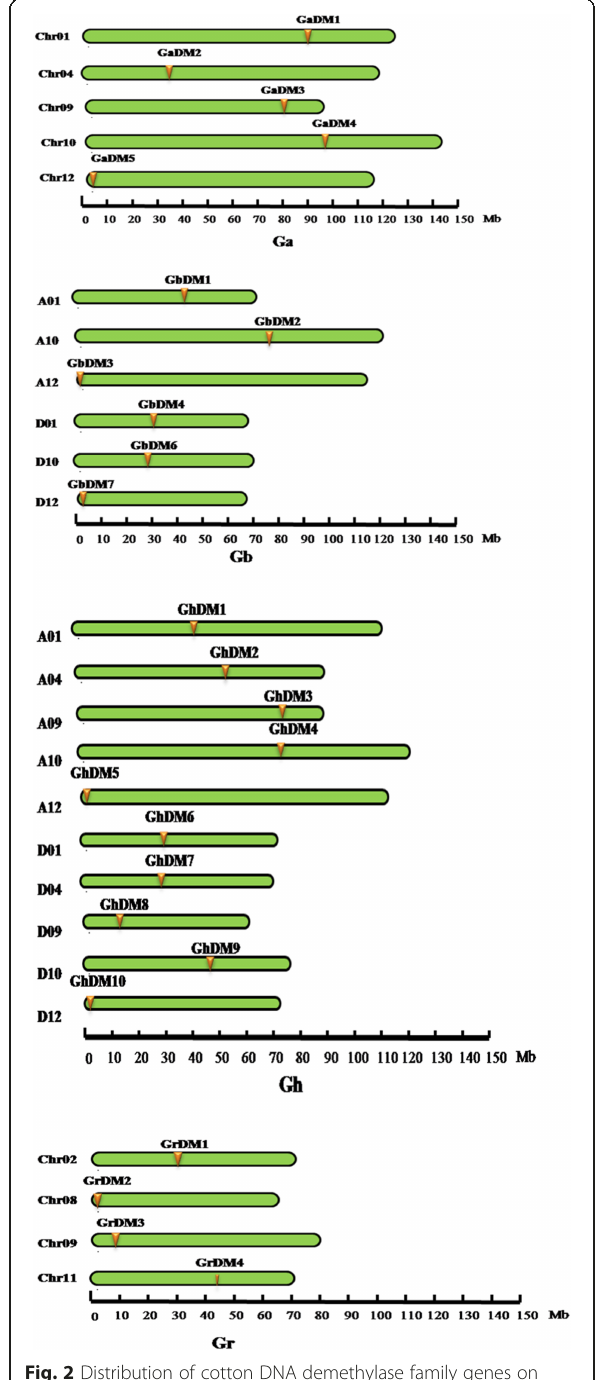
Fig. 2 Distribution of cotton DNA demethylase family genes on chromosomes. Ga: Gossypium arboretum L.; Gb: Gossypium barbadebse L.; Gh: Gossypium hirsutum L.; Gr: Gossypium